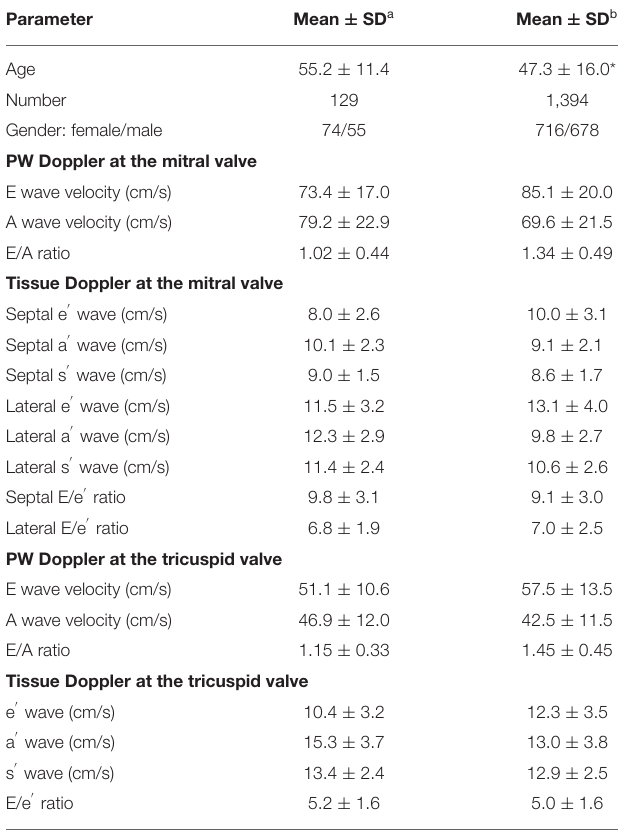
TABLE 1 | Cardiac Doppler parameters and features of primary varicose vein patients and the normal